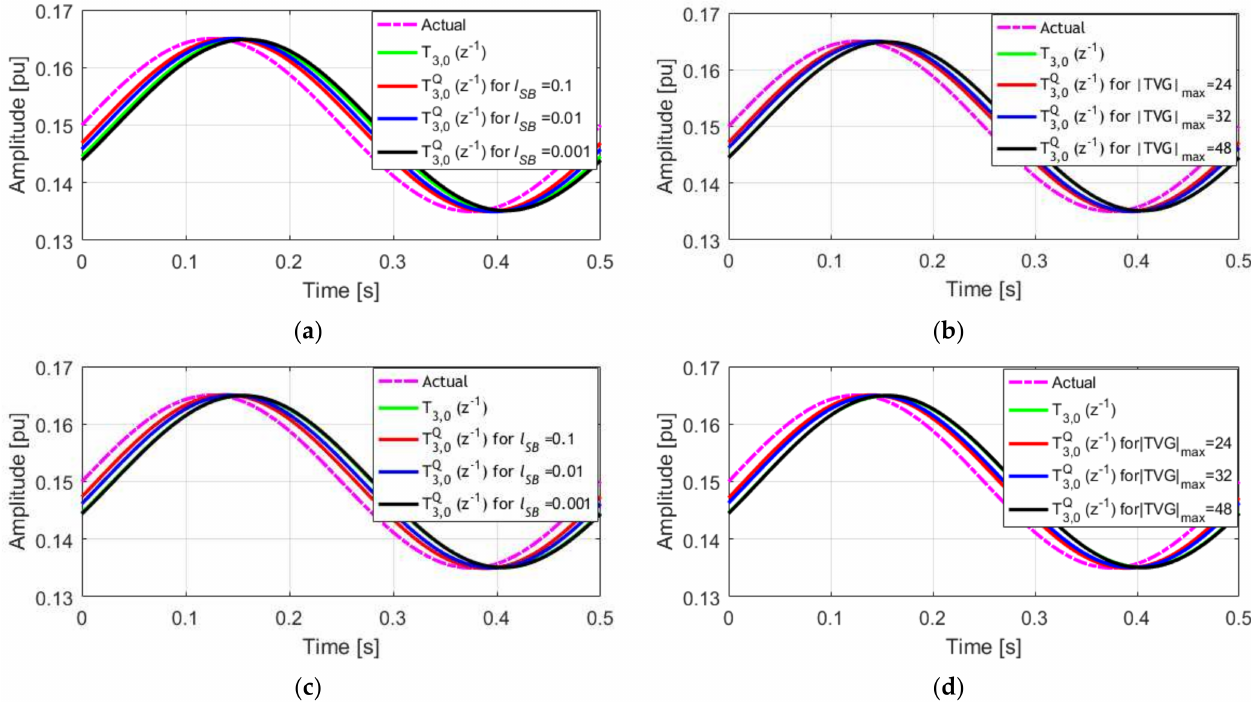
Figure 6. Simulation results obtained for the amplitude modulated signal with f m = 2 Hz for K = 2, and with f 1 = 50 Hz and f S = 1600 Hz for: ( a ) Task 1 for N Q = 16, ( b ) Task 2 for N Q = 16, ( c ) Task 1 for N Q = 32, ( d ) Task 2 for N Q =